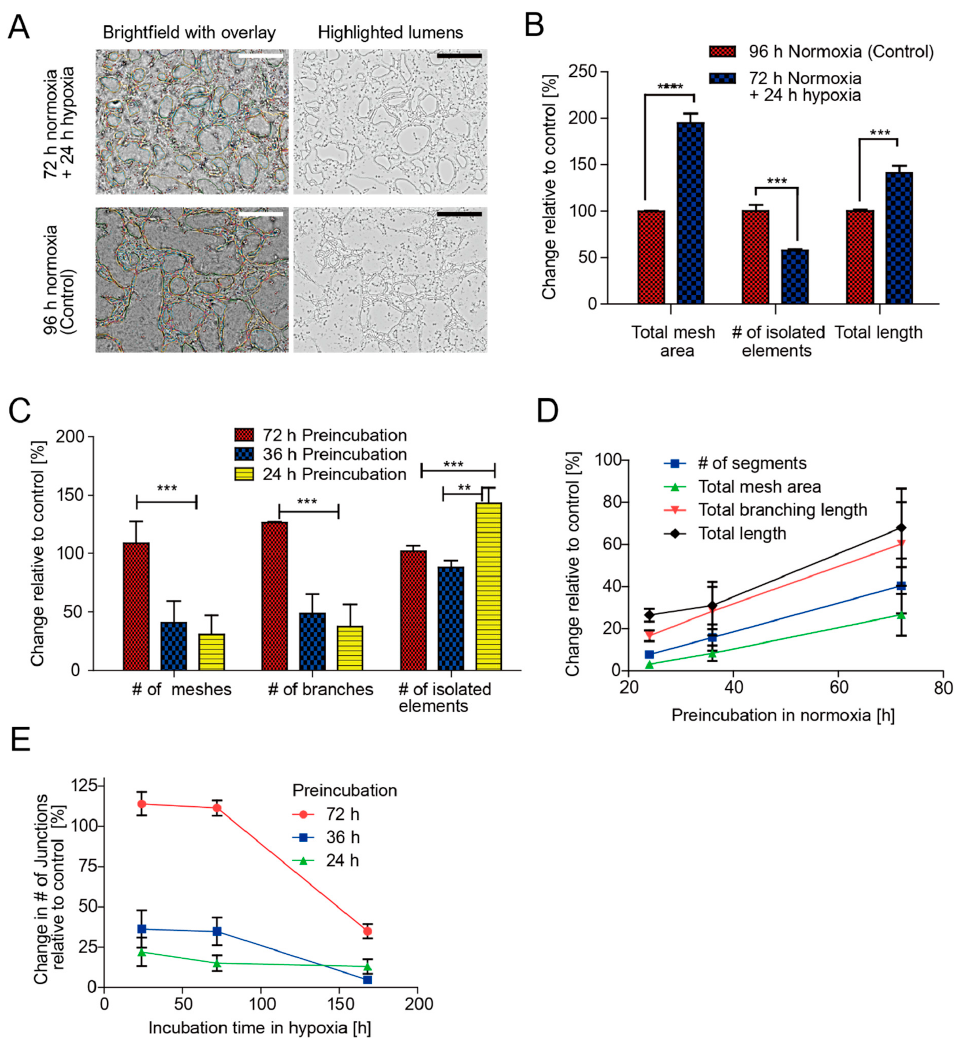
Figure 6. Angiogenic parameters of the vascular networks of HUVECs under di ff erent normoxic preincubations and followed by hypoxic transitions. Parameters increased with the time of normoxic preincubation and short periods of hypoxia exposure (24 h). Prolonged hypoxia decreased the angiogenic parameter values: ( A ) representative images of vascular networks of HUVECs cultured for 72 h normoxia / 24 h hypoxia and control cells (96 h normoxia) (scale bar = 150 µ m); ( B ) angiogenic parameters of cells cultured for 72 h normoxia / 24 h hypoxia and control cells (96 h normoxia); ( C ) angiogenic parameters in cells preincubated in normoxic conditions for 24, 36, and 72 h and switched to hypoxia for 24 h; ( D ) relationship between preincubation time in normoxia and vascular network parameters; ( E ) e ff ect of incubation in hypoxia on the relative change in the number of junctions. The standard deviation of the mean (standard deviation) is presented in all error bars, N = 3.